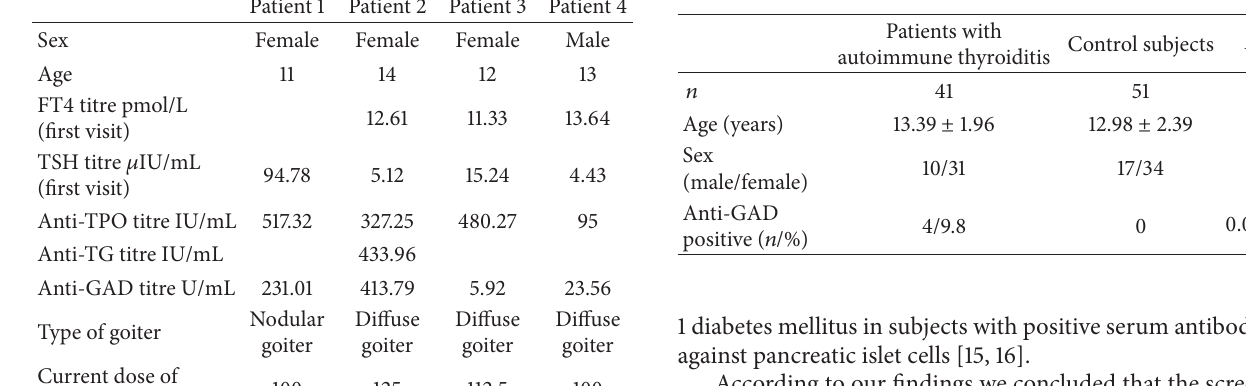
Table 2: Clinical characteristics of GAD positive patients. Table3:FrequencyofGADantibodiesinpatientswithautoimmune thyroiditis and the control